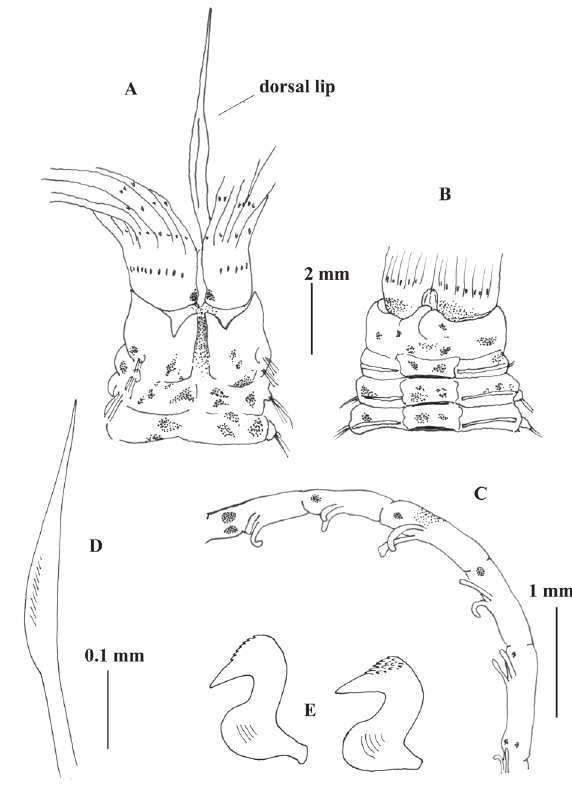
Fig . 7. – Branchiomma maerli n. sp.: A, anterior end, dorsal view; B, anterior end, ventral view; C, detail of radiole, showing stylodes and radiolar eyes; D, thoracic inferior notochaeta; E. thoracic uncini in different